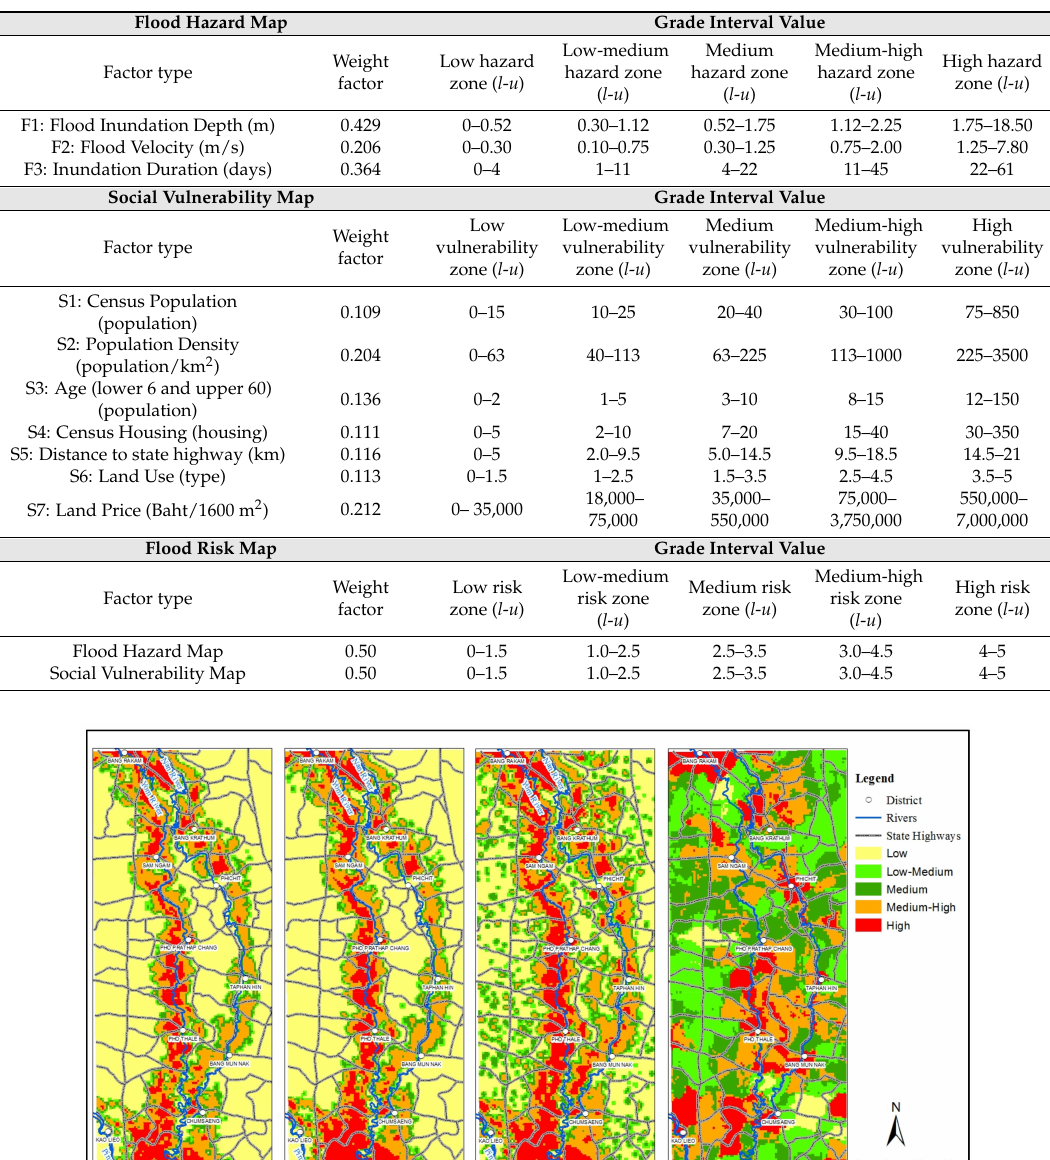
Table 3. The factors classification of the flood hazard map, social vulnerability map, and flood risk map including the triangular fuzzy members ( l , m , and u in Figure 3).